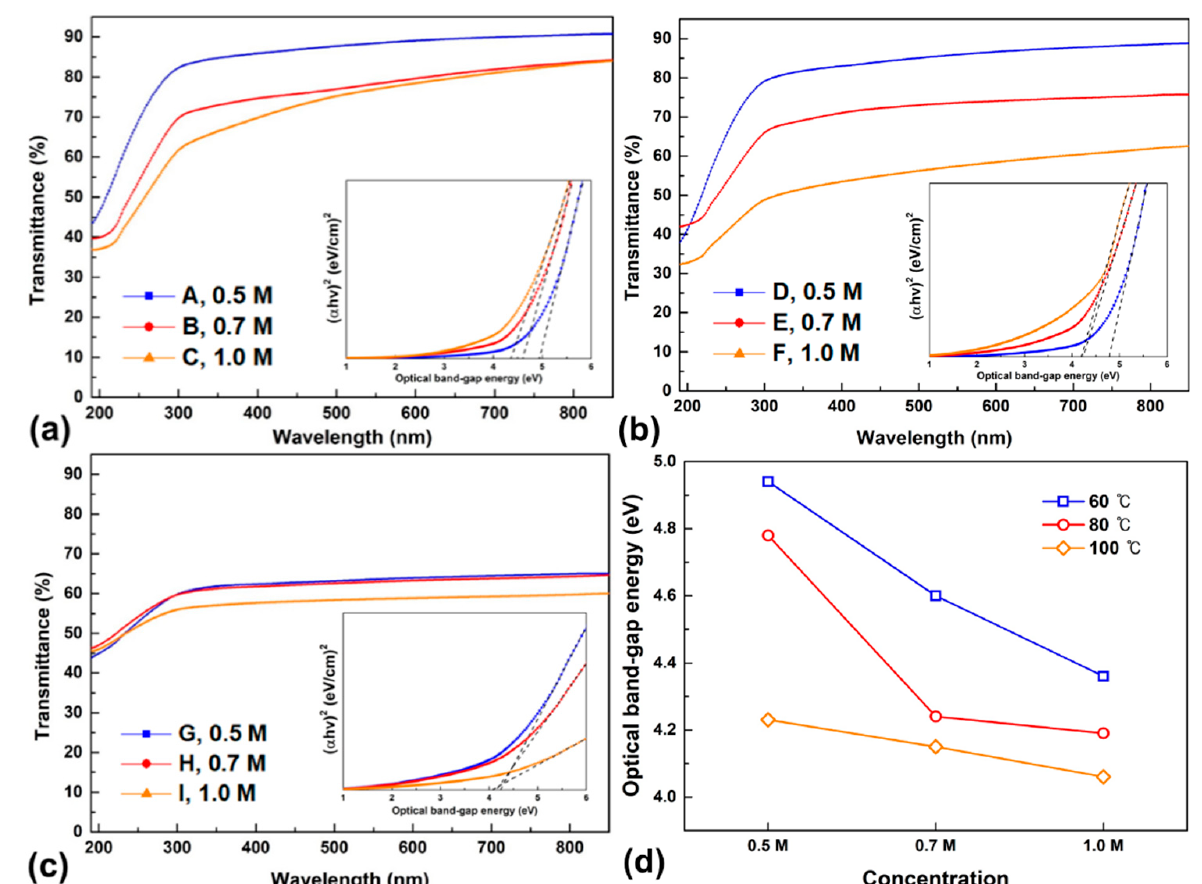
Figure 6. Optical properties of the as-deposited samples prepared at different molar concentrations and drying temperatures. Transmittance (%) values of different samples at drying temperatures of ( a ) 60 ◦ C, ( b ) 80 ◦ C, and ( c ) 100 ◦ C. ( d ) Optical bandgap energies of samples prepared at different drying temperatures using different molar